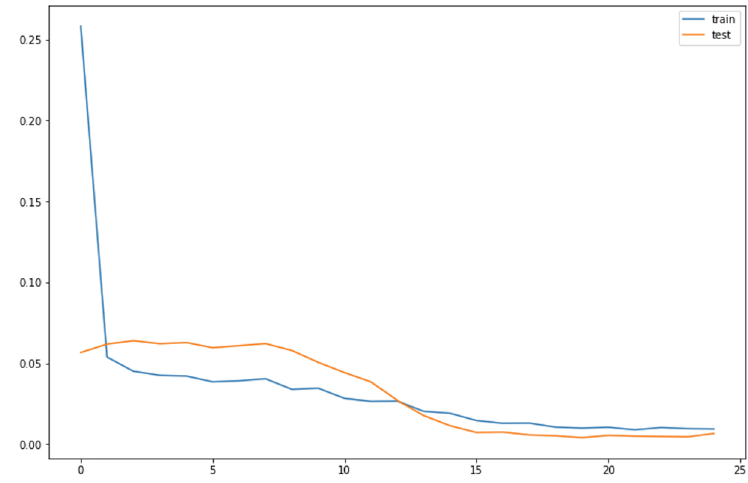
Figure 14. RMSE for train and test sets over 25 epochs without the usage of the proposed prefetch scheme.